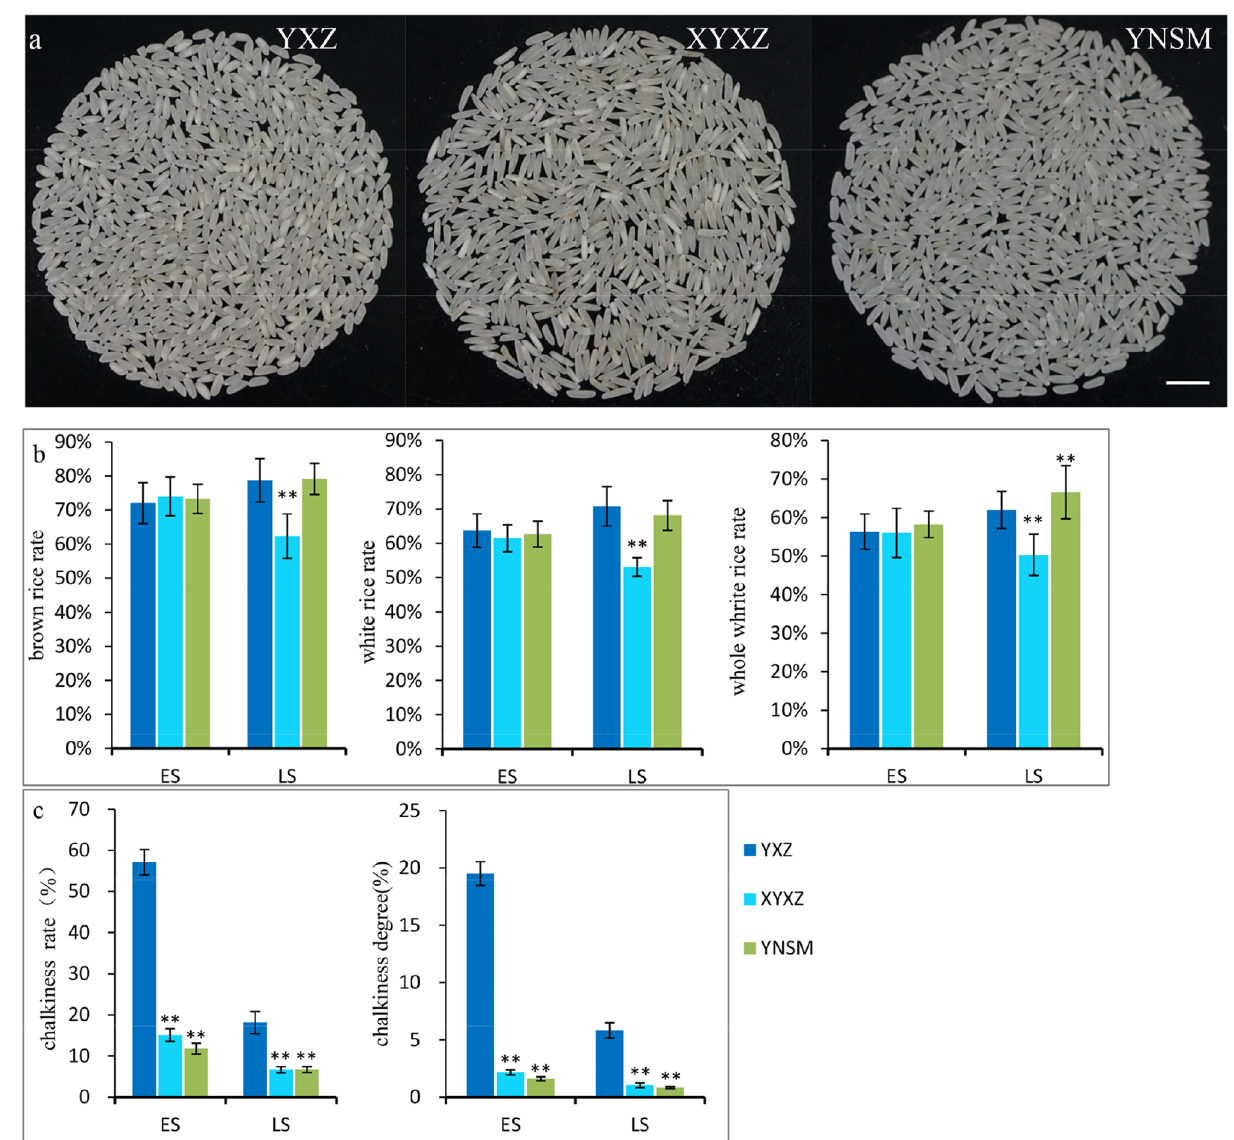
Figure 3. Milling quality analysis. ( a ), The appearance of milled rice; ( b ) and ( c ), Milling quality analysis. ES, early season, LS, late season. Bar = 1 cm. ES, early season; LS, late